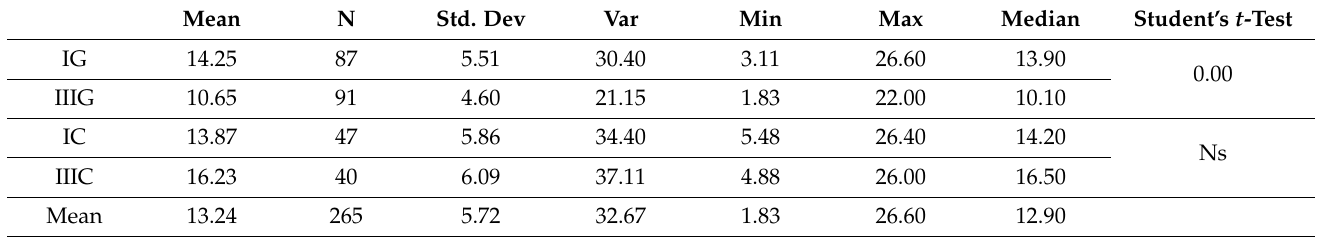
Table 4. Basic statistical parameters for the tensile strength [MPa] and results of the Student’s t -test for samples collected from the ground section (G) and breast height (C) from both trees.